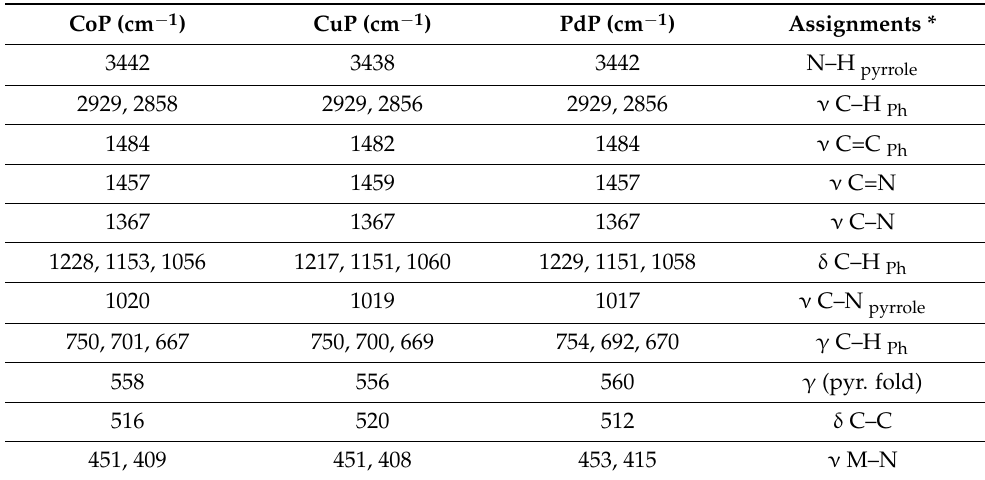
Table 1. Assignments of MPs in powder IR spectra.